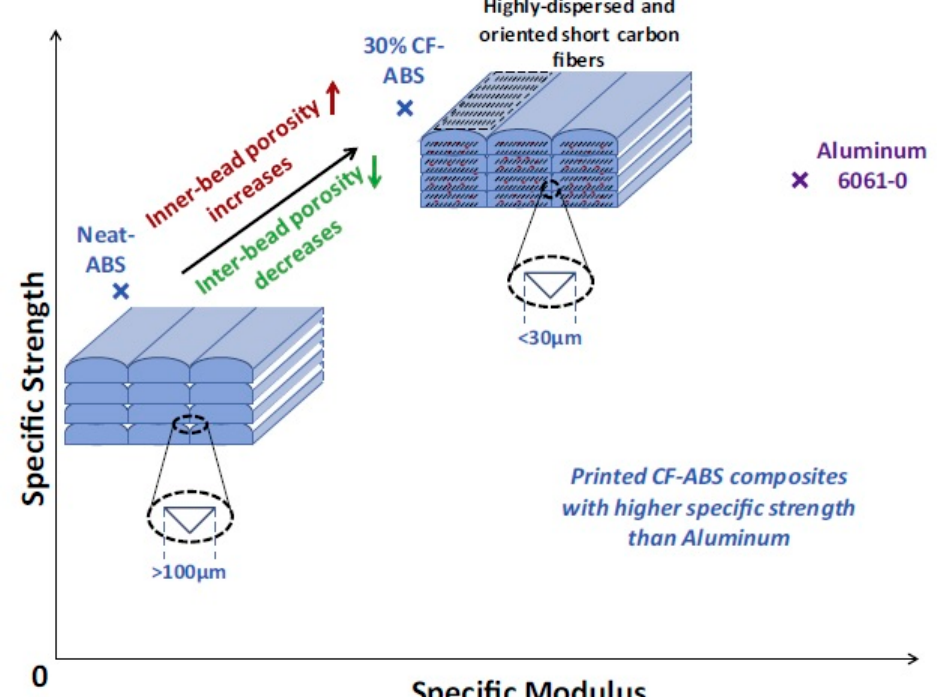
Figure2. Schematicpresentationof3D-printedfiber-reinforcedcompositebyfuseddepositionmodeling. Figure 2. Schematic presentation of 3D-printed fiber-reinforced composite by fused deposition Reprinted from [18], © 2014 with permission from modeling. Reprinted from [18], © 2014 with permission from Elsevier.